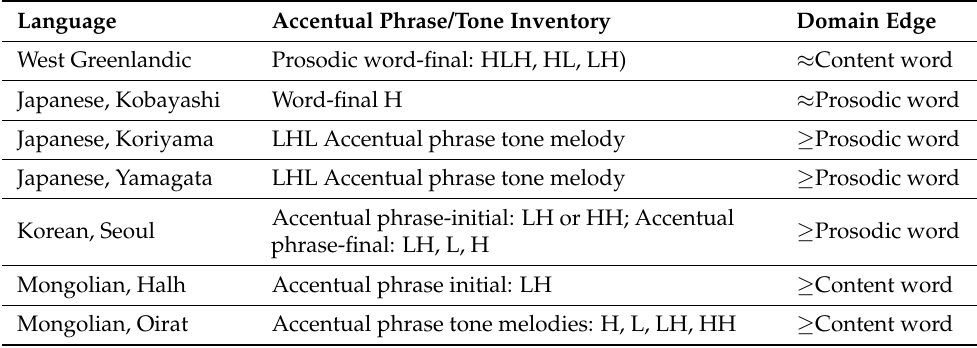
Table 1. Macro-rhythm of edge-prominence languages (adapted from Jun 2014: Table